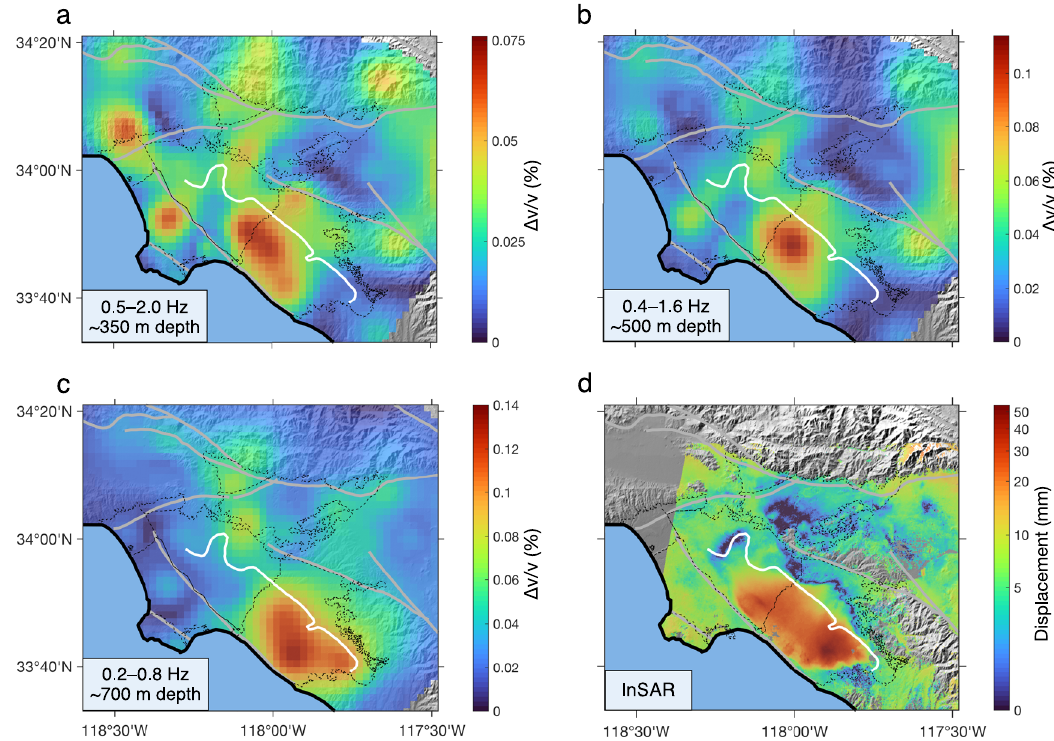
Fig. 3 | Seasonal variabilities of Δ v/v and surface deformation. a – c Maps showing the seasonal amplitude of Δ v/v measured in three decreasing frequency bands corresponding to increasing depths: a 0.5 – 2.0Hz, corresponding to about 350m depth; b 0.4 – 1.6Hz, corresponding to about 500m depth; c 0.2 – 0.8Hz, corresponding to about 700m depth. The depth sensitivities of seismic waves in